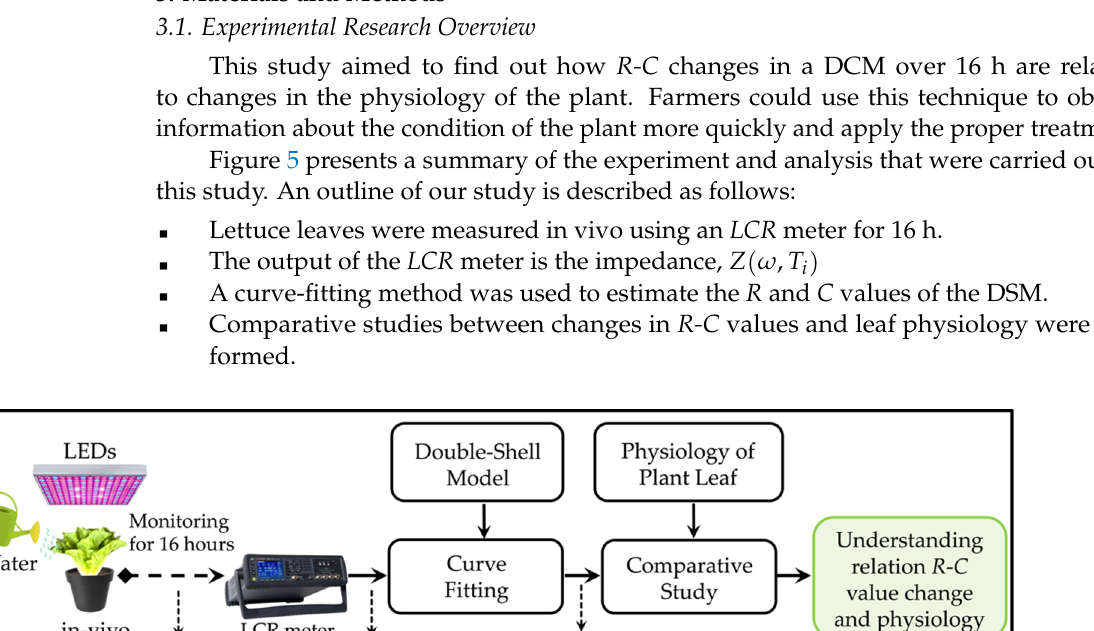
8 of 20 Figure 4. Electric current flows through biological tissue. At low frequencies, current flows through the ECF , while at high frequencies, current flows through both the ECF and the ICF . 2.3. LEDs and Indoor Plant Cultivation Artificial light sources have been used for a long time in the culture and growth room industries. These light sources include TFL, high-pressure sodium (HPS) lamps, metal halide lamps (MHLs), incandescent lamps, etc. TFL has been the most popular in the tis- sue culture and growth room industries. On the other hand, TFL uses up 65% of the total electricity in a tissue culture lab and is the highest nonlabor cost. As result, these industries are always looking for a better way to use light. LEDs have become a promising light